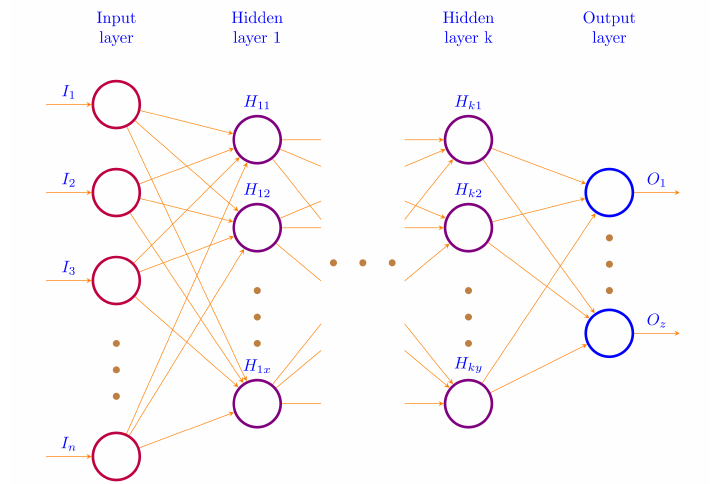
Figure 3. Architecture of a deep neural network model with one input, one output and k hidden layers.